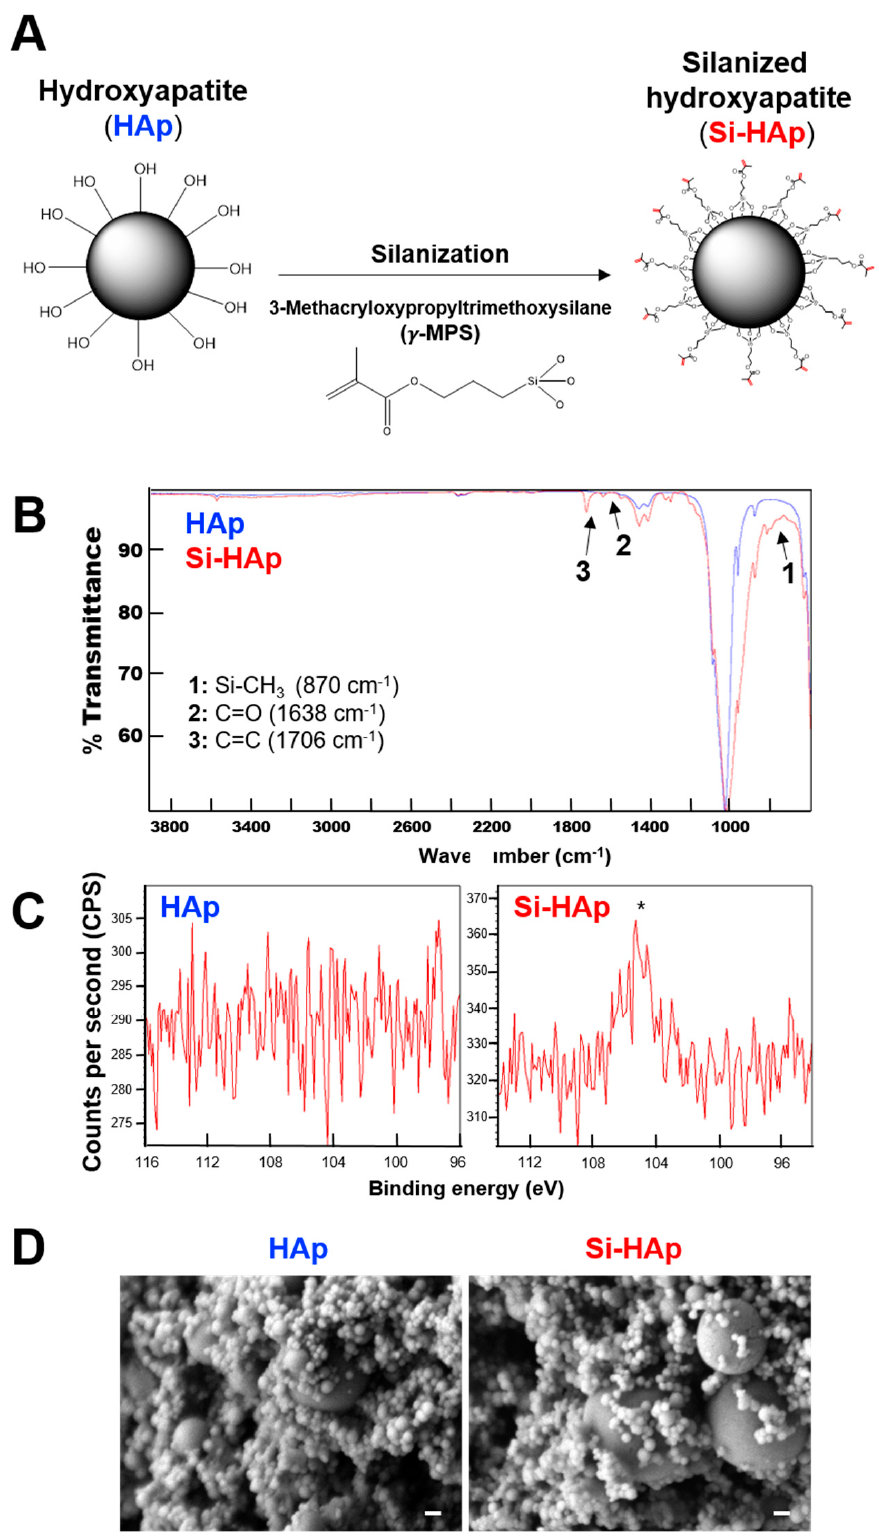
Figure 1. Surface modification of hydroxyapatite. ( A ) Schematic of the silanization of HAp nanopowder using 3-methacryloxypropyltrimethoxysilane. ( B ) ATR-FTIR spectra of HAp and Si-HAp. Characteristic peaks, 1: Si-CH 3 (870 cm -1 ), 2: C=O (1638 cm -1 ), 3: C=C (1706 cm -1 ). ( C ) X-ray photoelectron spectra of HAp (left) and Si-HAp (right). * Si 2p (Si-O) peak, ~104 eV. ( D ) Scanning electron microscopy images of HAp (left) and Si-HAp (right) particles. magnitude, 50,000×. Scale bar, 100 nm.